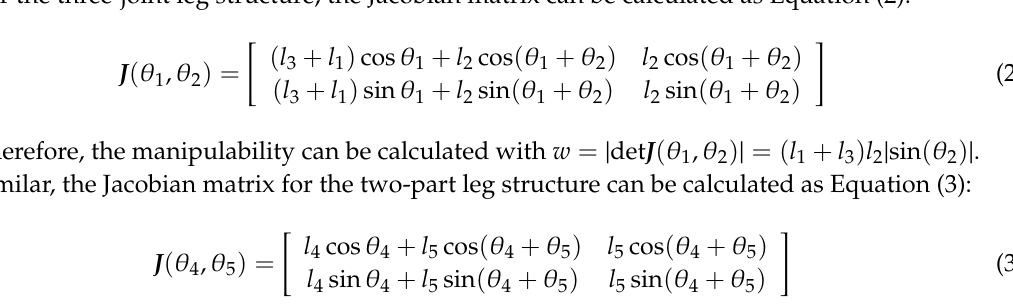
Figure 1. Schematic for the three-joint and two-joint leg structures.